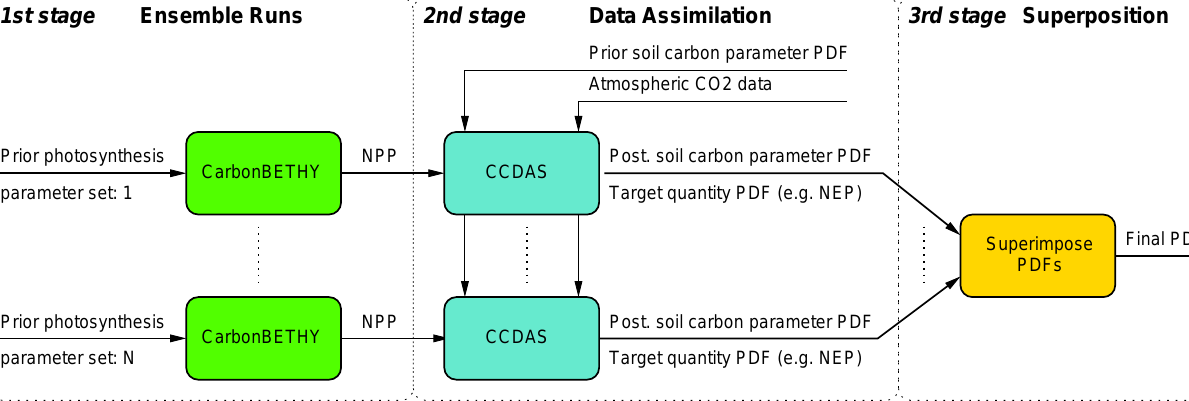
Fig. 1. Flow chart of the ensemble-adjoint optimization approach.